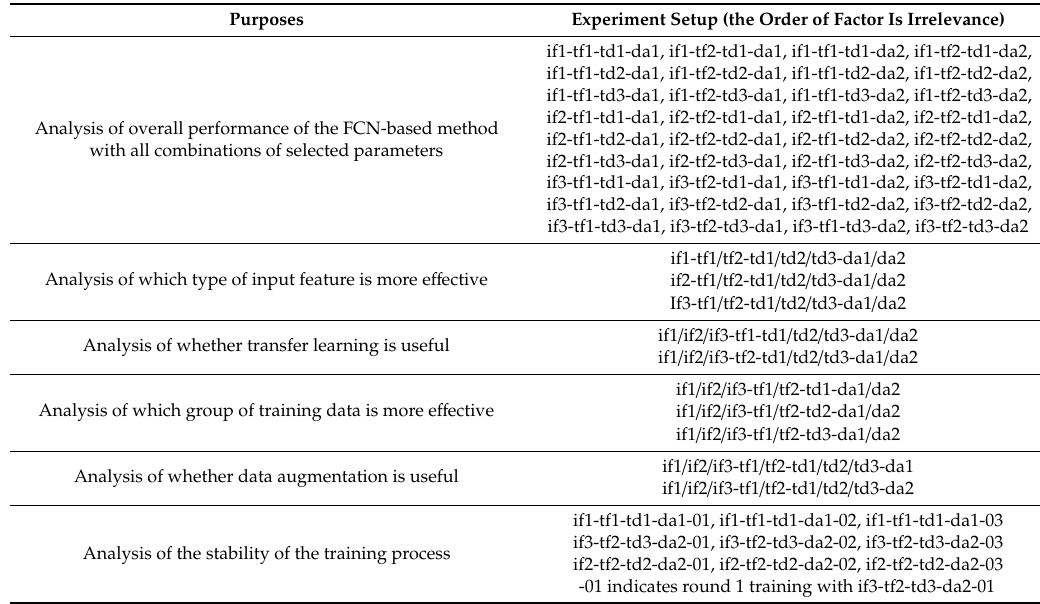
Table 2. List of experimental setups for analyzing overall performance of the FCN-based method and four key factors of the model,